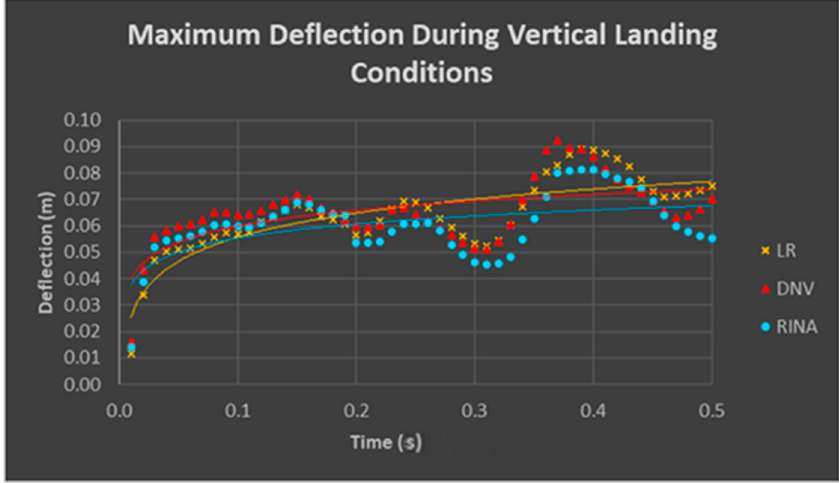
Figure 9. Maximum deflection of the deck plate under the vertical landing condition.